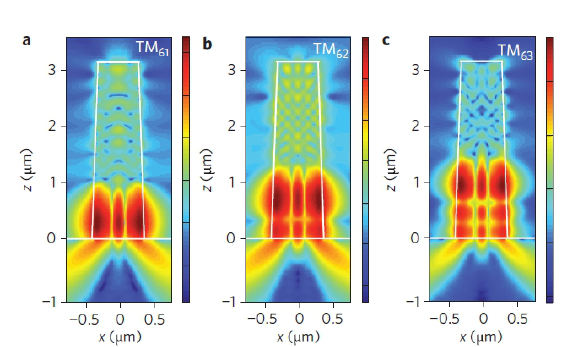
Figure 7: Effects of nanopillar sidewall taper on optical modes for a pillar on Si substrate. Vertical field profiles are shown of a nanopil- lar with 5 ∘ taper for (a) TM 61 , (b) TM 62 and (c) TM 63 modes. The modes are primarily confined at the base and become less reso- nant as they propagate upwards. (Reprinted with permission from Macmillan Publishers Ltd: Nature Photonics [105], ©